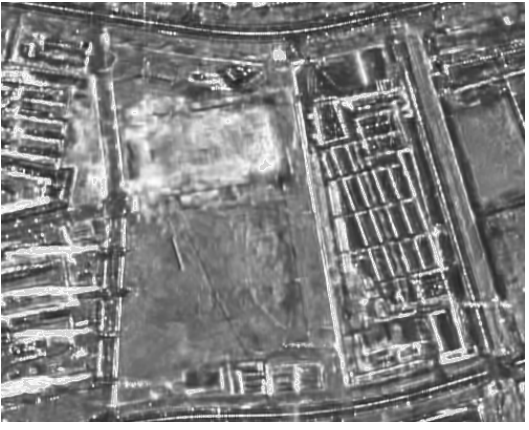
( b ) Data 1: Optical image from Google Earth, acquired in 14 September 2012